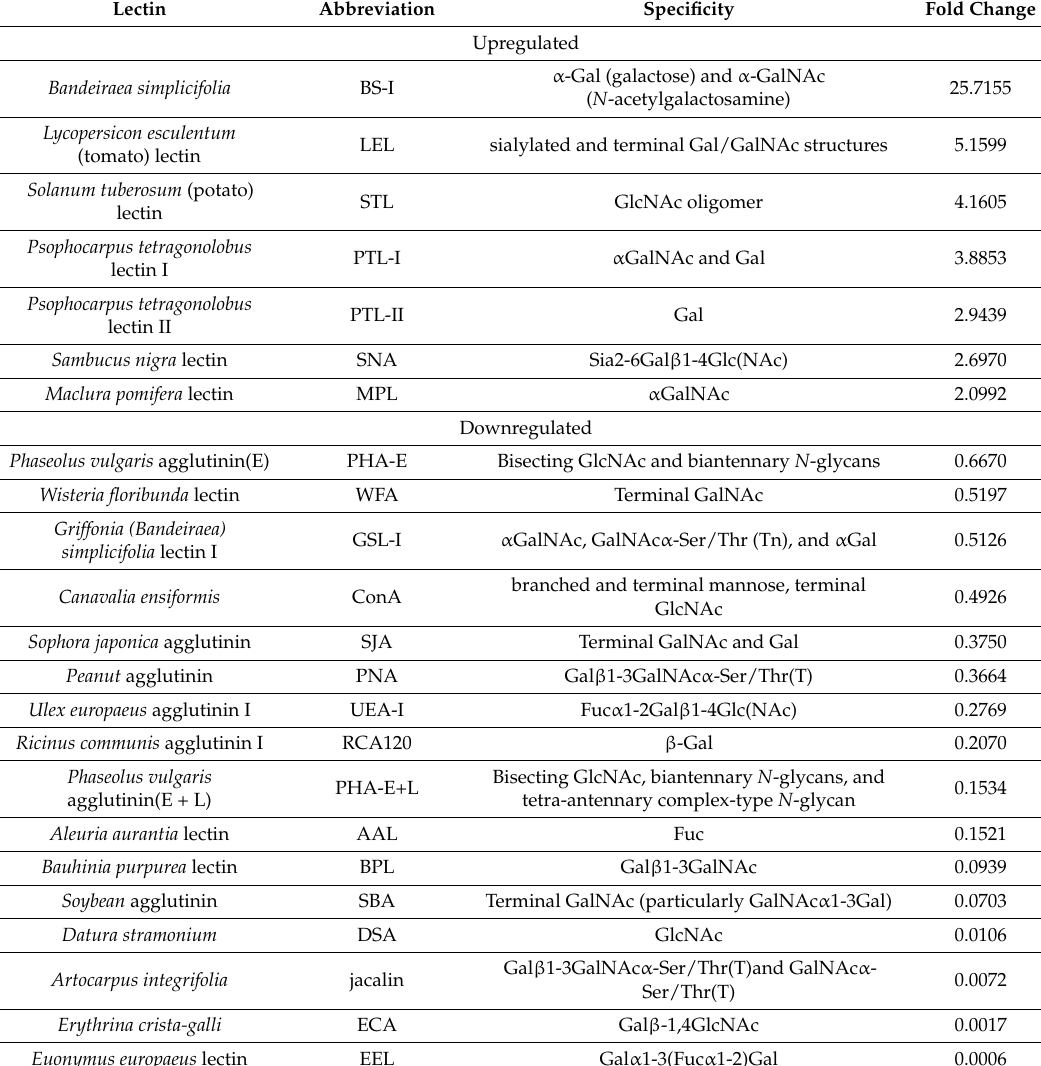
Table 3. Lectin microarray analysis of glycans showing significantly different expression in DMEM/1% FBS-incubated vs. 231-CM-treated MCF10A